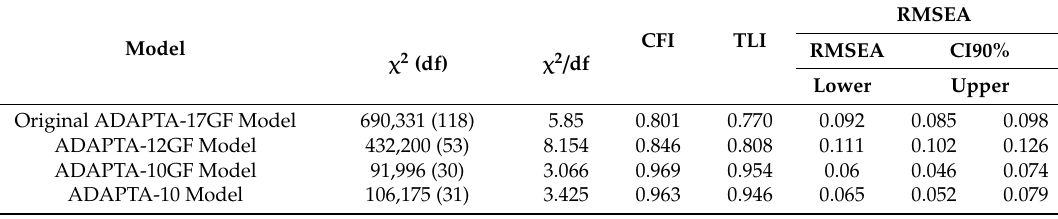
Table 2. Fit indices for the models proposed (calibration sample n =